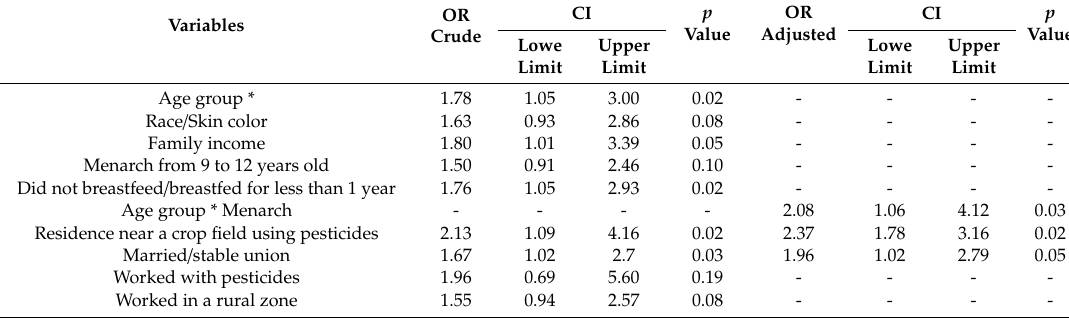
Table 5. Final analytical model for the occurrence of breast cancer, Rondon ó polis-MT, November 2017 to April 2018. Variables